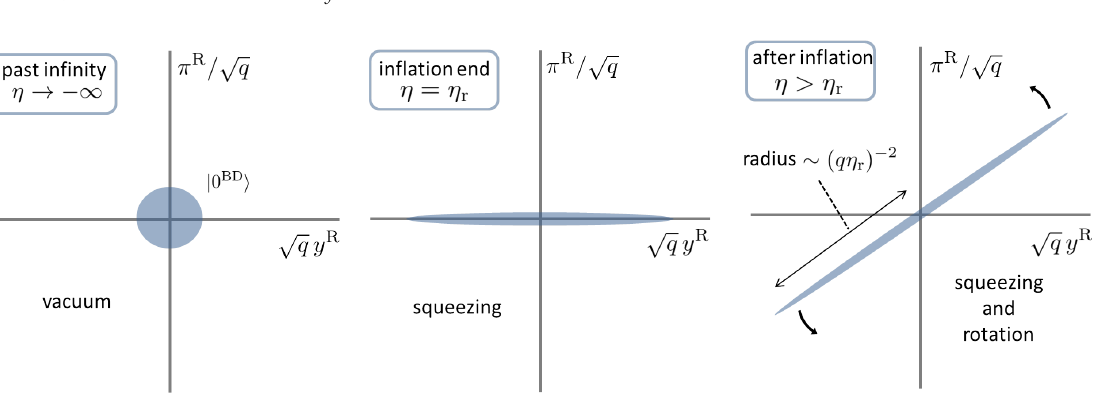
Figure 1. The behavior of the Wigner ellipse of the Bunch–Davis vacuum in the phase space √ √ ( q y R , π R / q ) . Left panel: the initial vacuum at the past infinity. Middle panel: the squeezed Wigner ellipse at the end of inflation. Right panel: the squeezed and rotated ellipse after the inflation. In Figure 1, the left panel represents the initial vacuum state at the past infinity η → − ∞ and the middle panel represents the squeezed vacuum by the inflationary expansion. The right panel shows the Wigner ellipse after the end of inflation for a sub-horizon mode. The Wigner function is further squeezed until the horizon re-entry. After that the Wigner ellipse rotates during the radiation and matter era. (Its thickness is around ¯ h = 1 in the right panel of Figure 1; however, it can be ignored in (37). The oscillation of the correlation function corresponds to the rotation of the Wigner ellipse in the phase